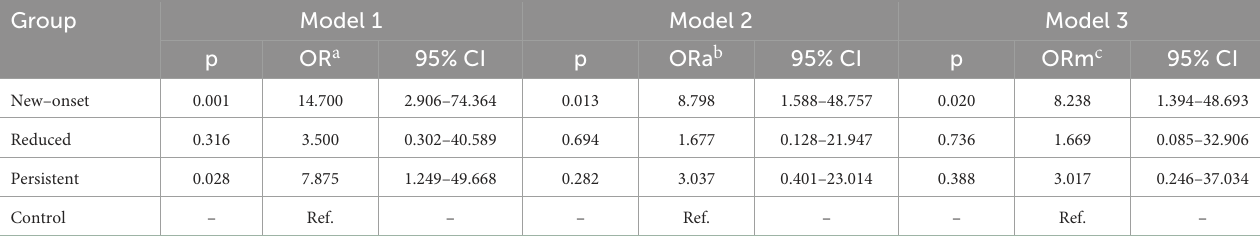
TABLE 3 Models of entrapment exposure with risk of suicidal ideation.